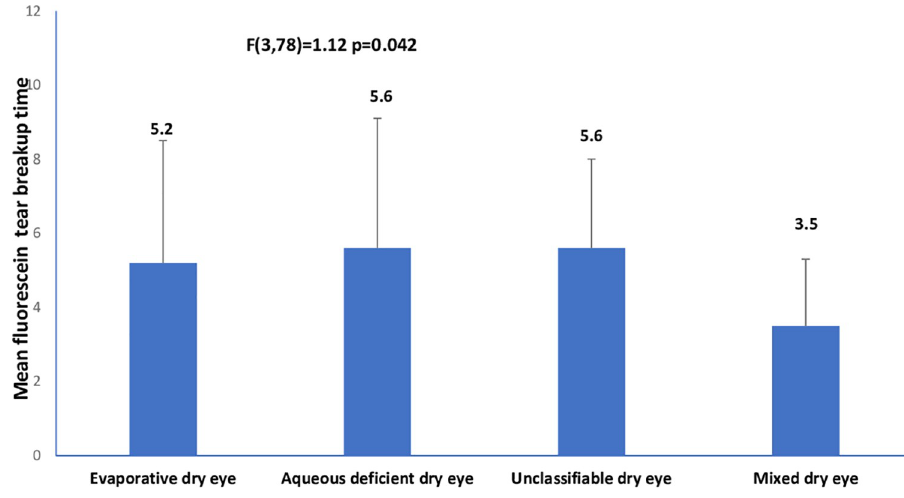
Fig 3. Means of fluorescein tear breakup time across clinical subtypes of dry